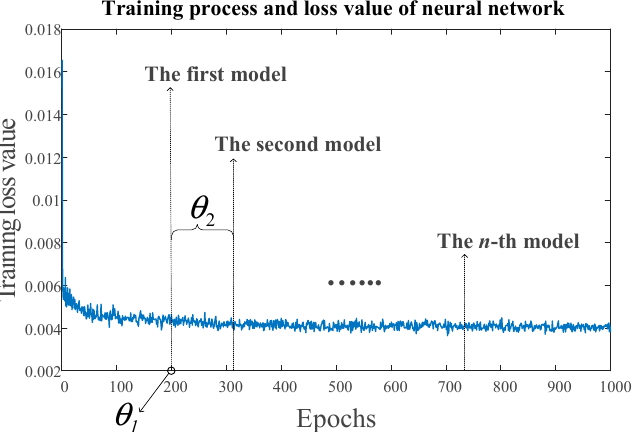
Figure 5. Illustration showing the typical behavior of the training loss value as a function of the number of training epochs; the definition of parameters θ 1 and θ 2 is clarified graphically (see the text for details).